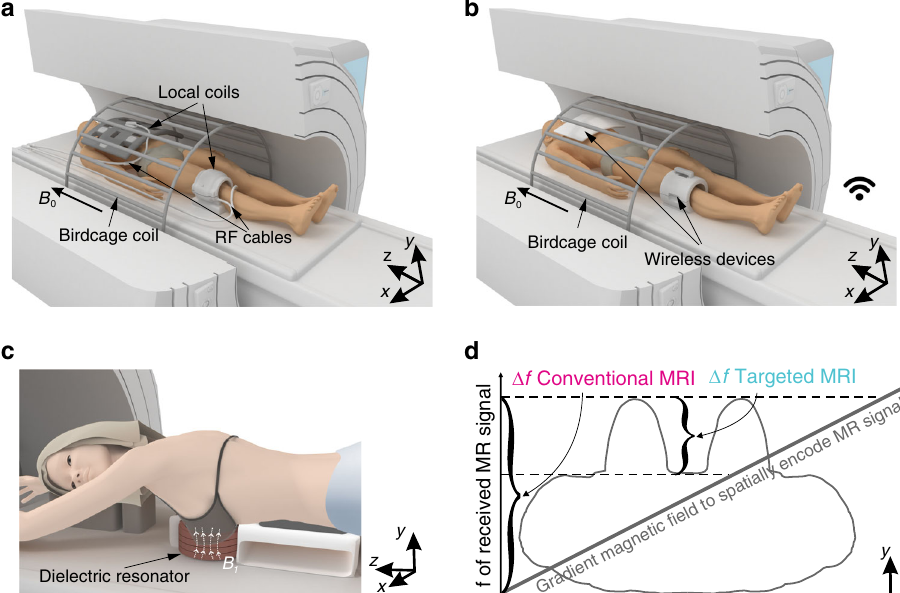
Fig. 1 Conventional and targeted concepts of MRI. a An illustration of a conventional acquisition scheme in the clinical MR systems. A body-sized RF resonator ( “ birdcage coil ” ) placed in the wall of an MR system bore excites the MR signal, while multiple surface RF coils located directly on a patient ( “ local coils ” ) receive MR signal and cabling system through a patient table delivers it to a spectrometer. B 0 indicates the direction of the static magnetic fi eld of an MR system. b A targeted MRI concept. The same large body resonator excites and receives MR signal while a wireless device localizes both exciting and receiving RF magnetic fl uxes of the body resonator to the region of interest. c An illustration of the actual experimental setup of targeted MRI for breast at 3 Tesla: the RF magnetic fi eld ( B 1 - fi eld) is confounded to the dielectric resonator cavity where a breast is located. d The gradient magnetic fi elds are always used during MR examinations to encode the MR signal through its frequency and phase. In the targeted MRI, the received signal bandwidth is limited to the size of the area of interest, while in the conventional MRI, the signal bandwidth is always proportional to patient body size. A signi fi cant reduction in the received signal bandwidth (in the phase-encoding direction) is bene fi cial for the total acquisition time of high-resolution imaging of the area of interest because of a decreased Nyquist frequency in the phase encoding